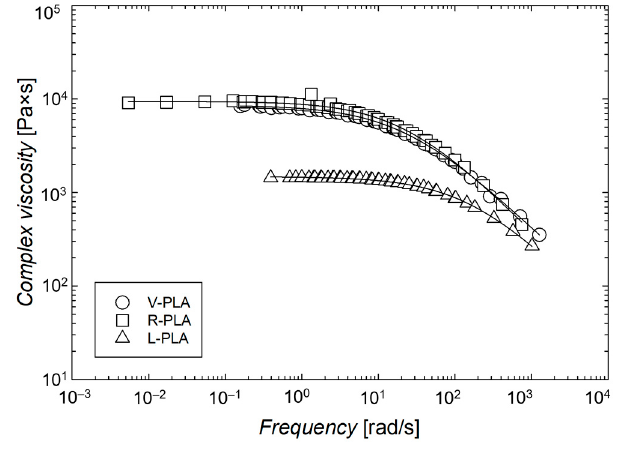
Figure 4. Reduced complex viscosity vs. reduced frequencies at the reference temperature T 0 = 170 °C.